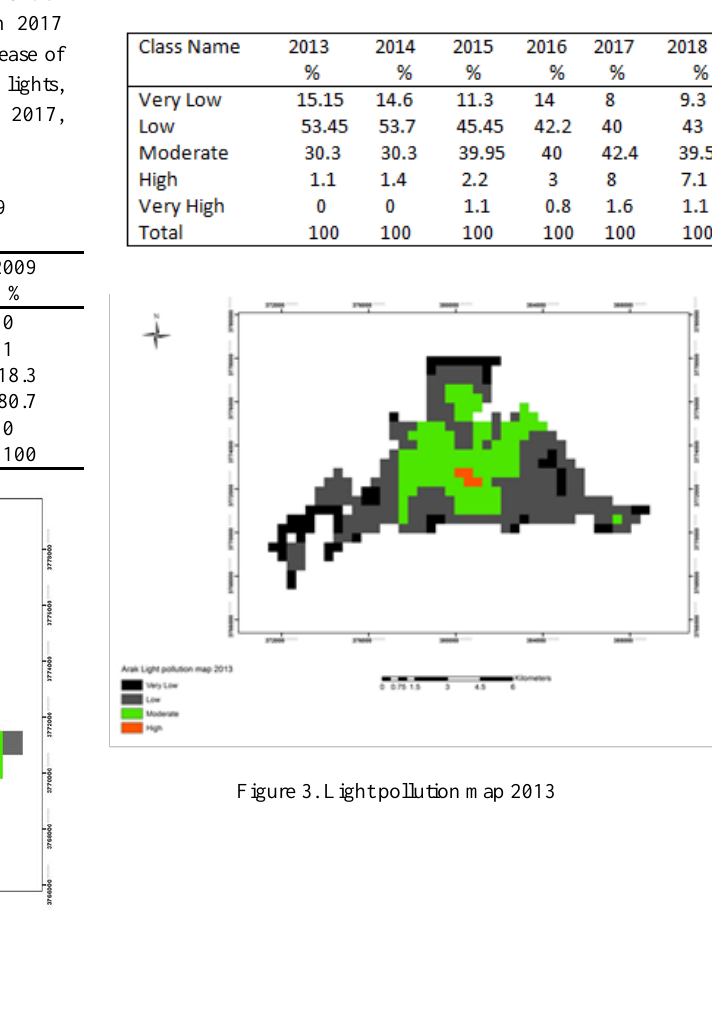
Figure 2. Light pollution map 2009 Table 2- Light pollution in 2013-2018